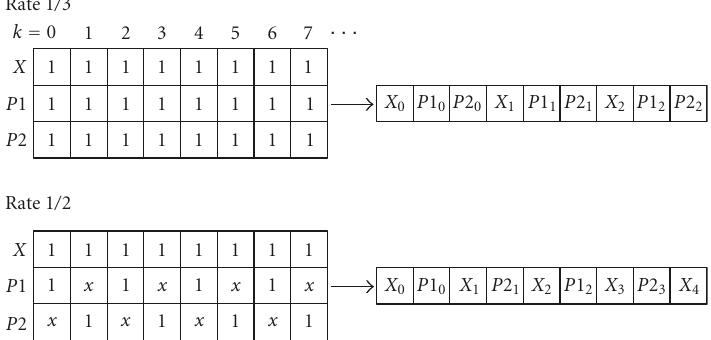
Figure 9: Puncture process of di ff erent code rate turbo code (“1” in the table means the code bit is included, “ x ” means the code bit is punctured).